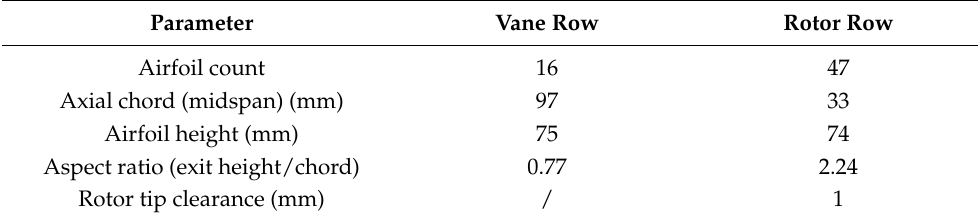
Table 1. Geometrical parameters. Parameter Vane Row Rotor Row Airfoil count 16 47 Axial chord (midspan) (mm) 97 33 Airfoil height (mm) 75 74 Aspect ratio (exit height/chord) 0.77 2.24 Rotor tip clearance (mm) /